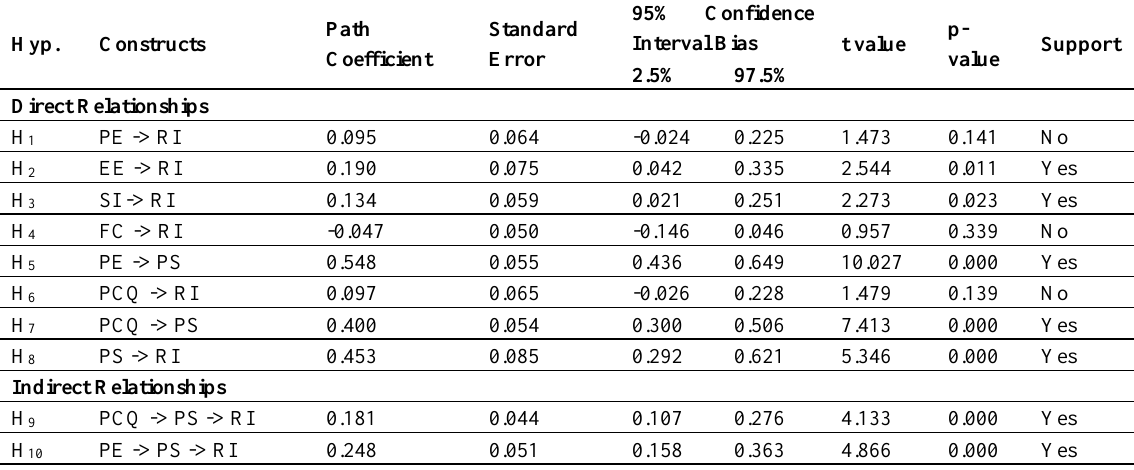
Table 5: Hypotheses Testing